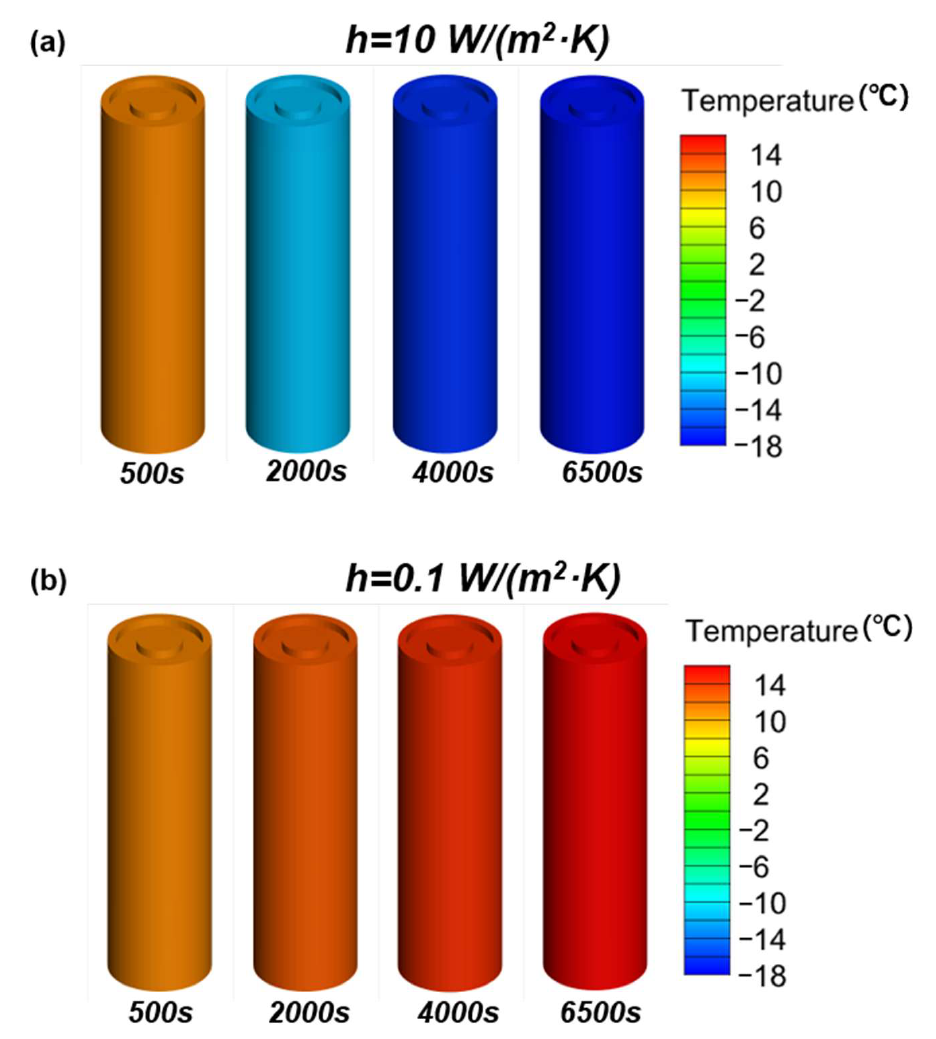
Figure 4. Surface temperature contour of the battery at 0.5C at different moments of discharge: ( a ) Without insulation; ( b ) With insulation.